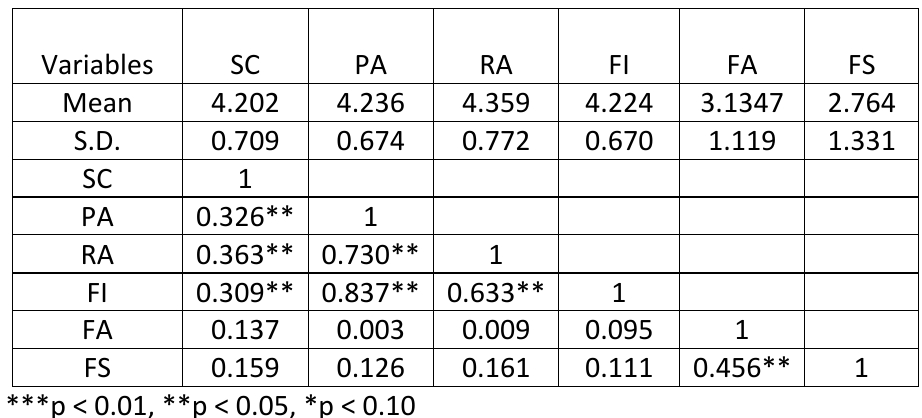
Table 2: Means, Standard Deviations, Factor Correlations.